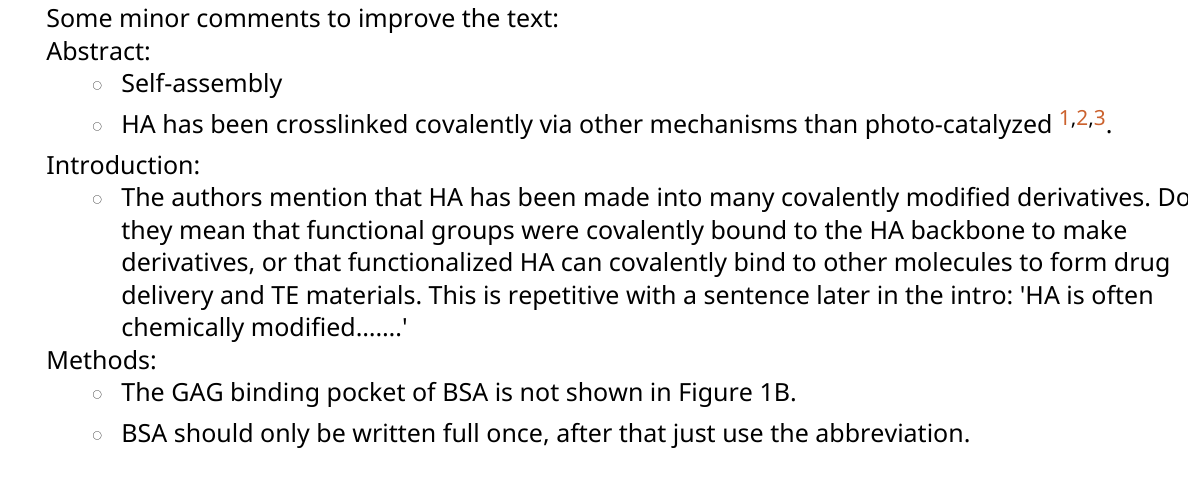
Figure 4: As Rhodamine is fluorescent, you can show fluorescent images to demonstrate the diffusion of the molecule into the